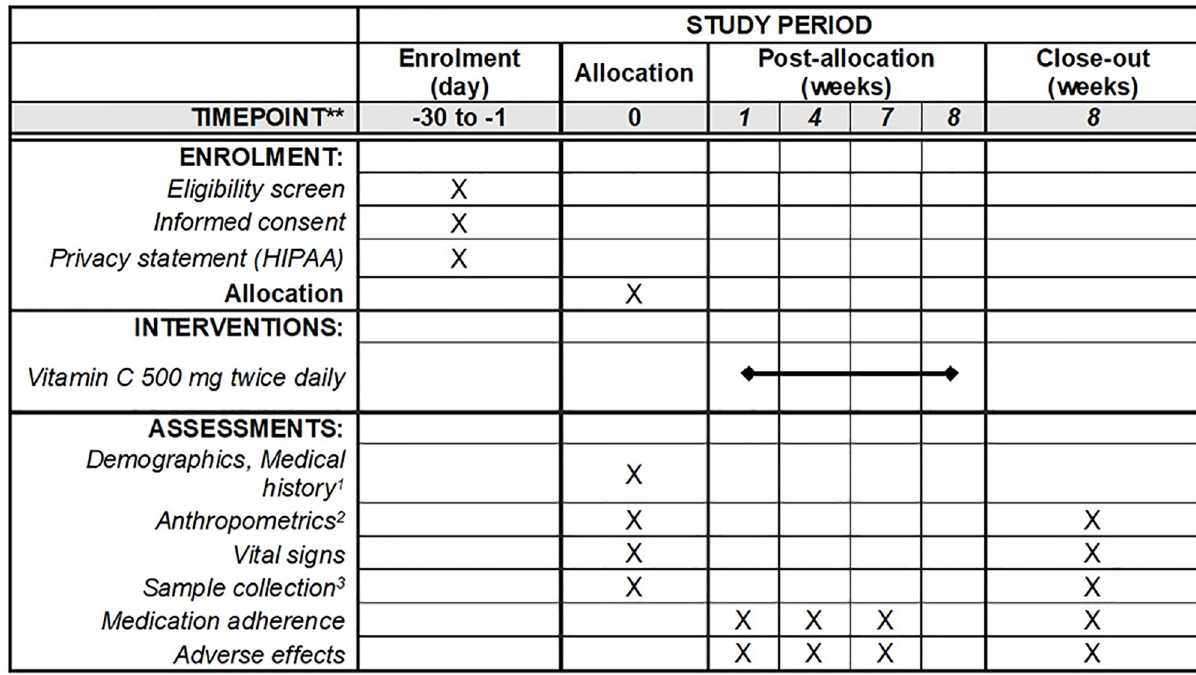
Fig 1. Schedule of enrollment, interventions, and assessments for the Hmong Microbiome ANd Gout, Obesity, Vitamin C (HMANGO-C) study. (Adopted from SPIRIT 2013 Figure.), 1 Include pregnancy status, COVID-19 vaccine status, and dietary history, 2 Include height, weight, and waist circumference, 3 Two stool samples in two consecutive days, a clean-catch urine sample, a saliva sample, and a blood sample.